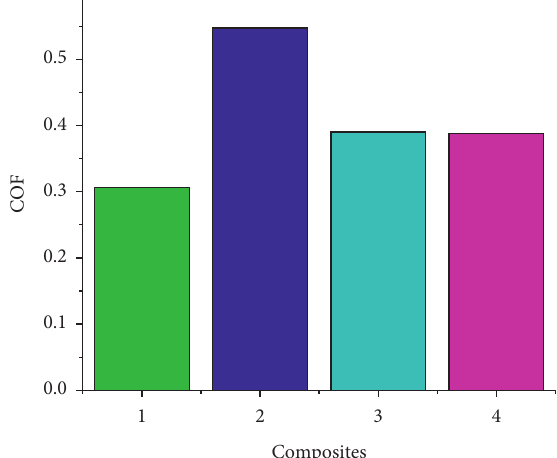
Figure 9: The coefficient of friction of the developed composites. (1) Mg alloy; (2) coated Al 2 O 3 ; (3) coated SiC; (4) coated Al 2 O 3